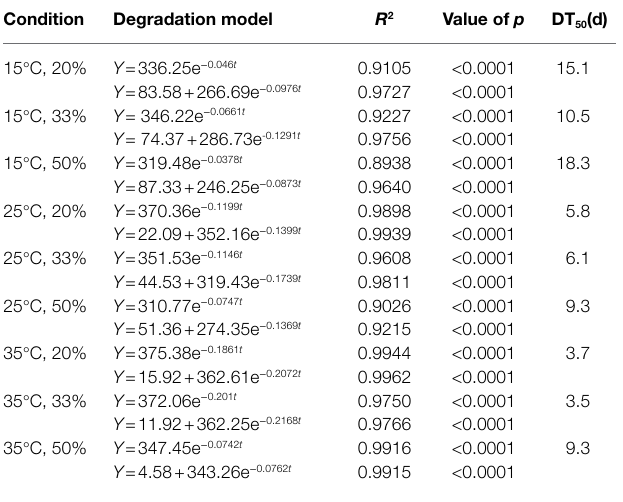
TABLE 2 | Degradation model of Cry1Ah protein in the soil collected from Gongzhuling (the results for the other soil types are shown in Supplementary Table S3